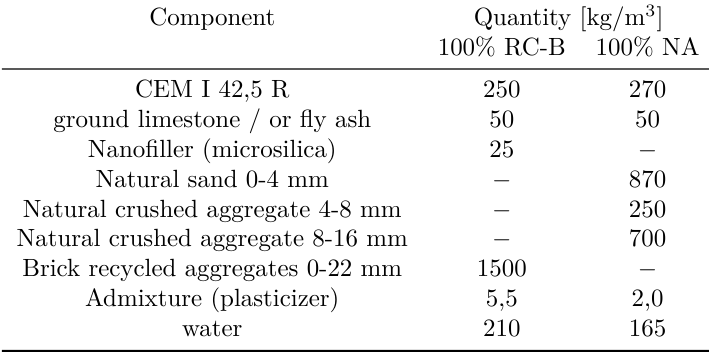
Table 5. Comparison of concrete mix design for C 20/25 with RA and NA.